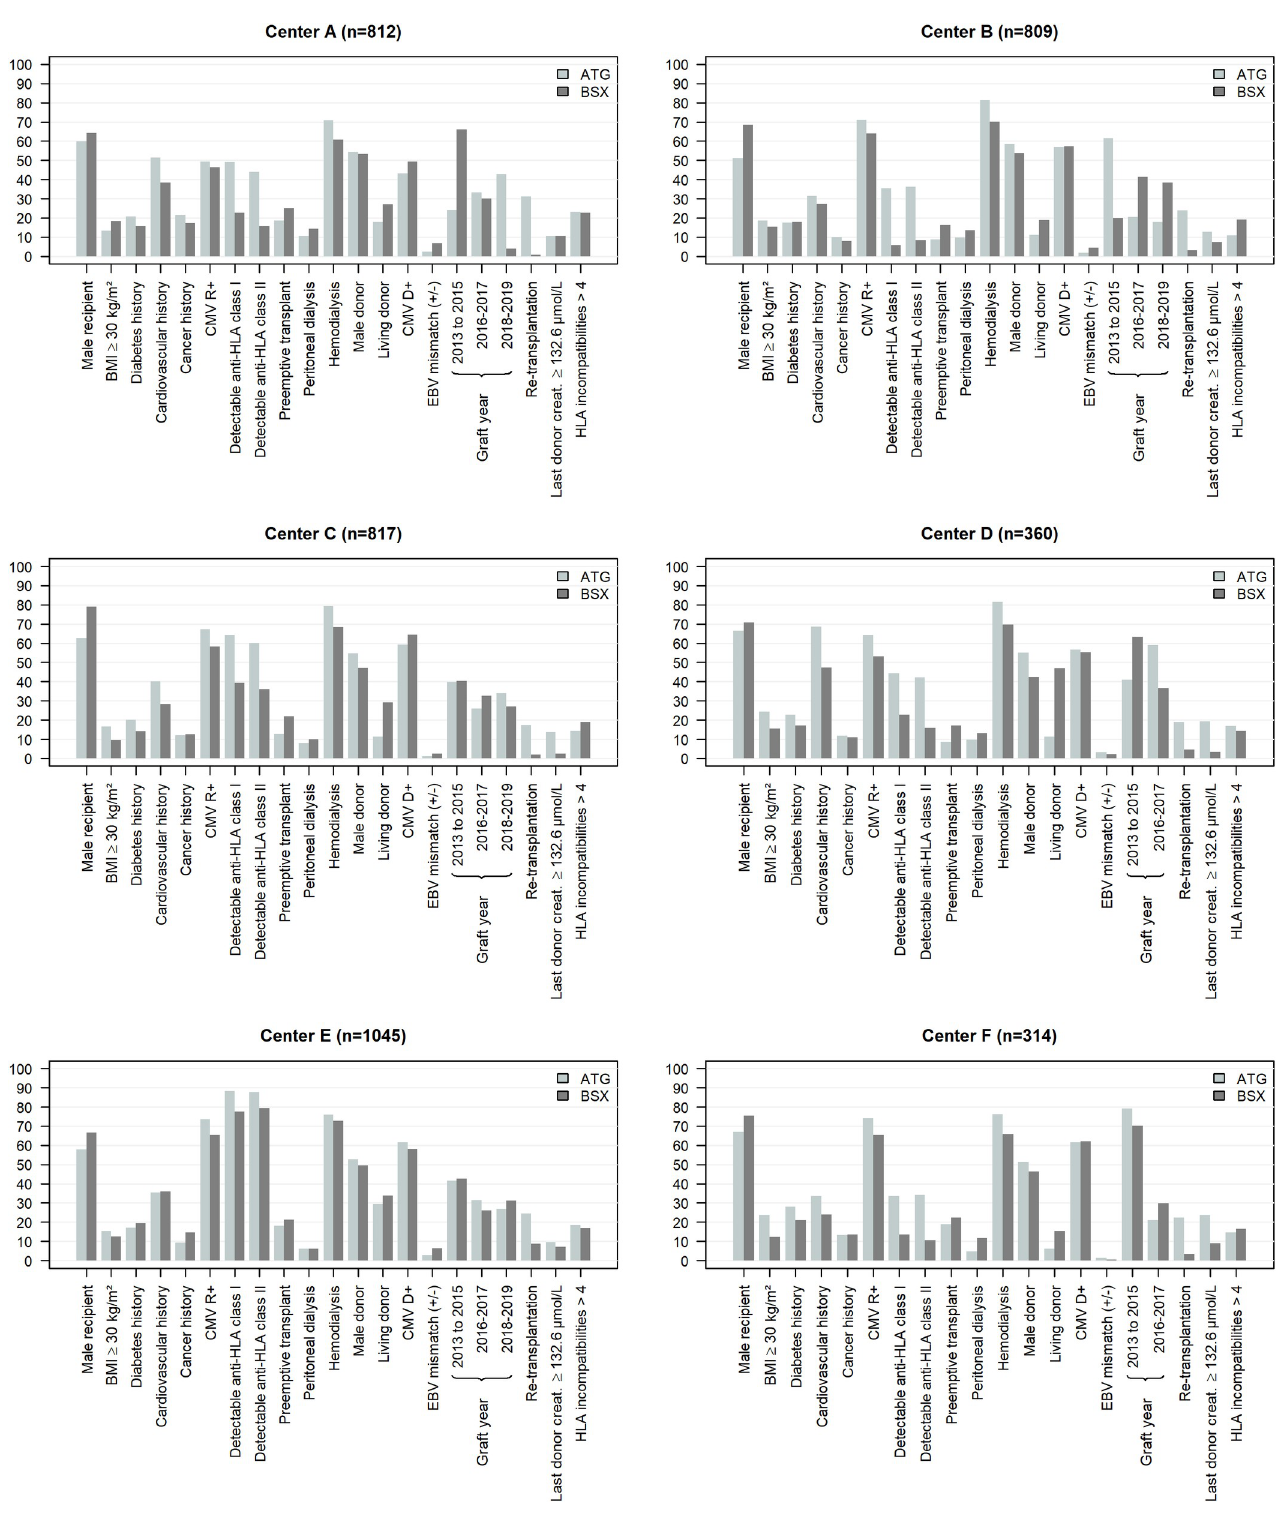
Fig 1. Description of the characteristics of kidney transplant recipients according to induction therapy and center (n = 4157).